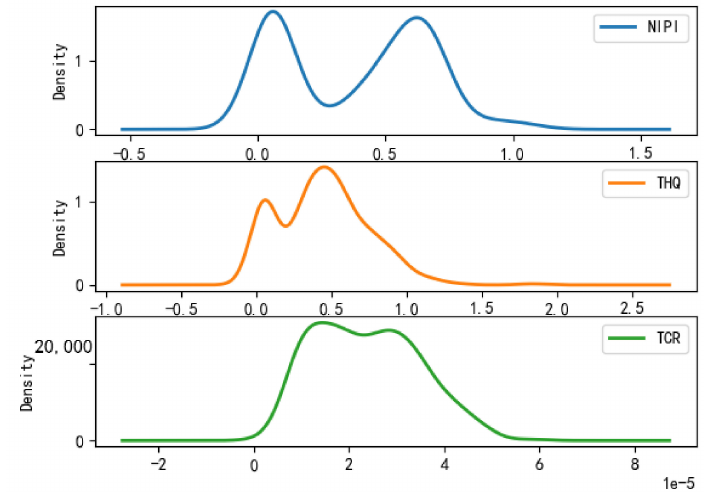
Figure 8. Plot of probability density function of Category 1.